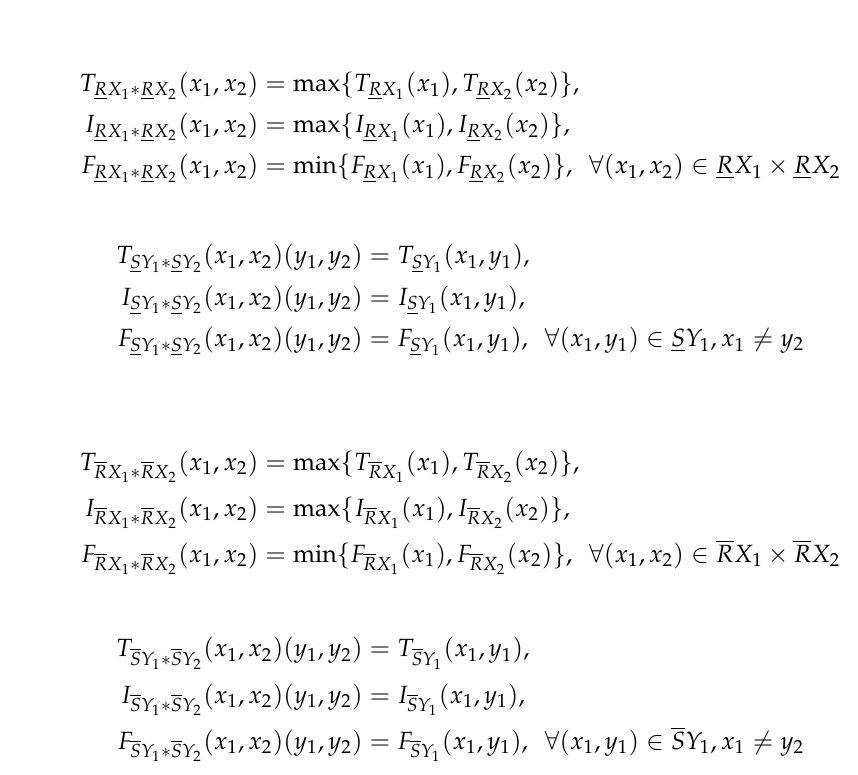
G , G 1 G 2 ) 1 ⊕ 2 G 2 , G 1 G 2 ) ⊕ ⊕ ⊕